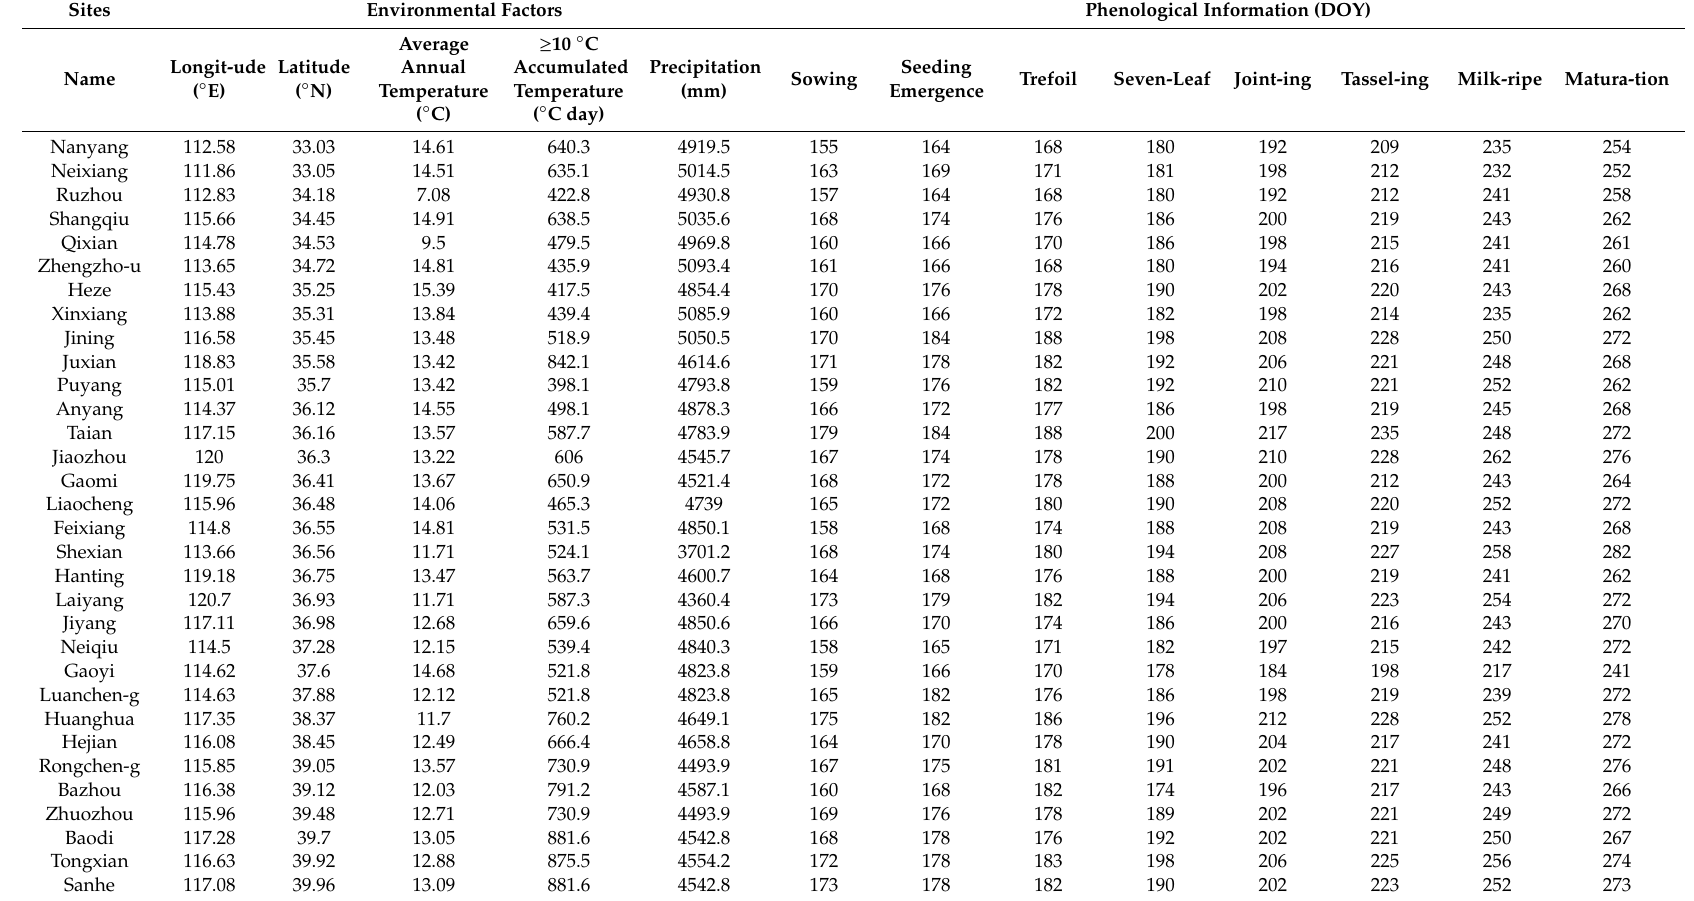
Table 1. Phenology and environmental factors of summer maize in Huanghuaihai Plain in